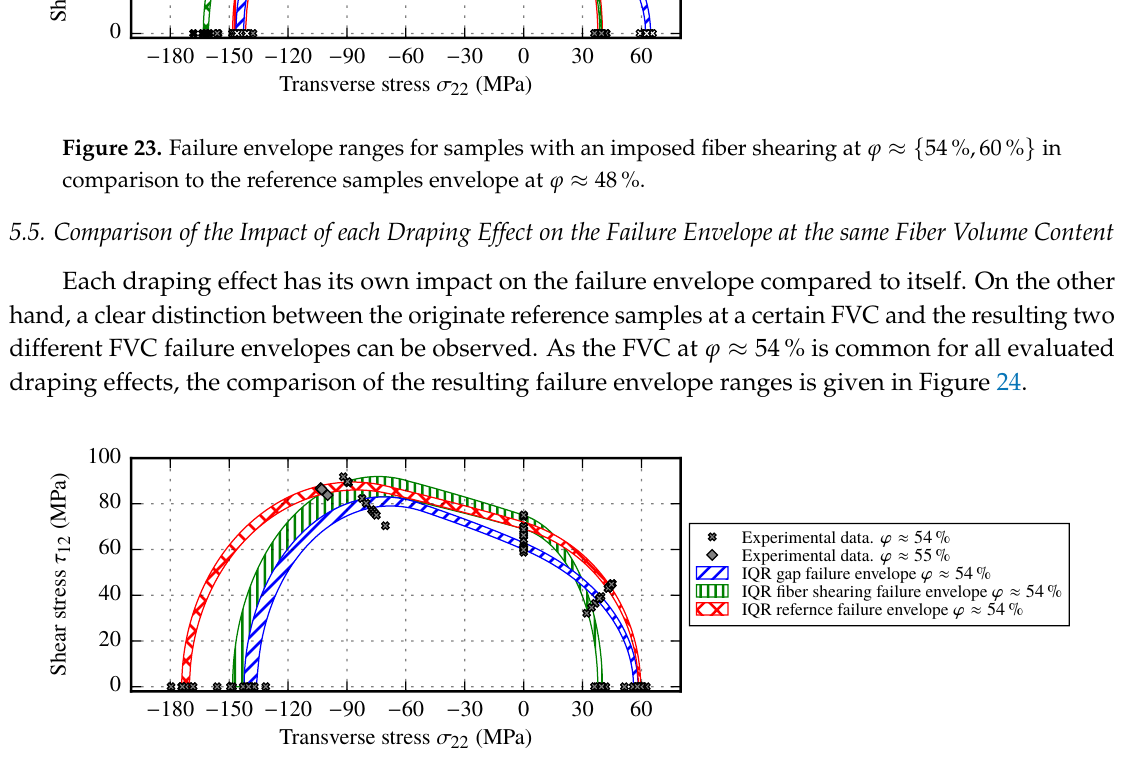
Figure 24. Comparison of the failure envelope ranges for reference samples, samples with gaps and samples with imposed shear at the same fiber volume